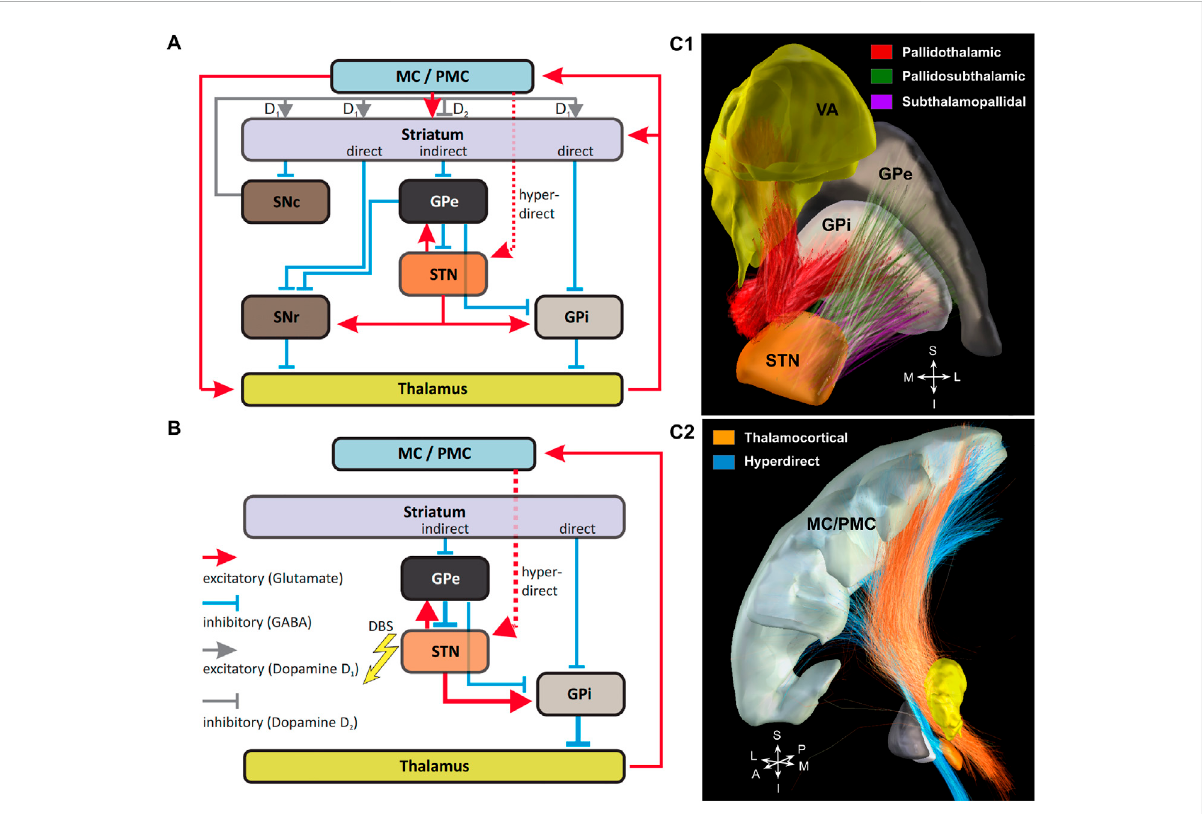
FIGURE 1 Basal ganglia-thalamo-cortical circuits. (A) : Circuit model comprising all main connections. MC/PMC — motor and premotor cortical regions, respectively. For explanations, please see the main text. (B) : Simulated reduced circuit model with highlighted (bold arrows) connections possibly affectedbySTN-DBS.ThesynapticconnectionbetweenStriatumandGlobusPallidusparsexterna/interna(GPeandGPi)weremodelledbydifferent constant currents. (C) : Structural connectivity of the simulated network is based on the pathway atlas of human motor network constructed from multimodal data including diffusion, histological and structural MRI data, fused to a virtual 3D rendering Petersen et al. [36]. (C1) : Projections fromGPito thalamus (VAnucleus) areshown inred,connections between subthalamic nucleus(STN)andGPeare showningreen,projectionsfrom STN to GPi are shown in violet. (C2) : Connections between motor cortex (MC/PMC) and the thalamus projections were obtained by classifying fi ber tracts from Marek et al. [37] and are shown in orange. Projections from motor cortex to STN (hyperdirect pathway) are shown in blue. Nuclei are shown inthe following colours: GPe in lightgrey, GPi indark grey, STN indark orange, thalamus (VAnucleus) inyellow and motor cortex (M1) inlight